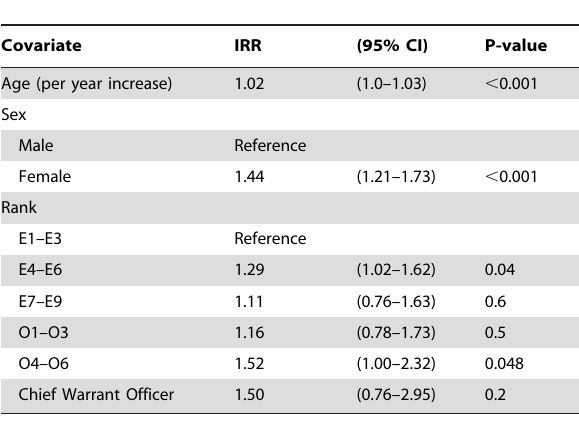
Table 4. Multivariate negative binomial regression of the association between rate of self-reported respiratory infection and covariates, Qatar Clinic health screening questionnaire Feb 2005 to Feb 2006.